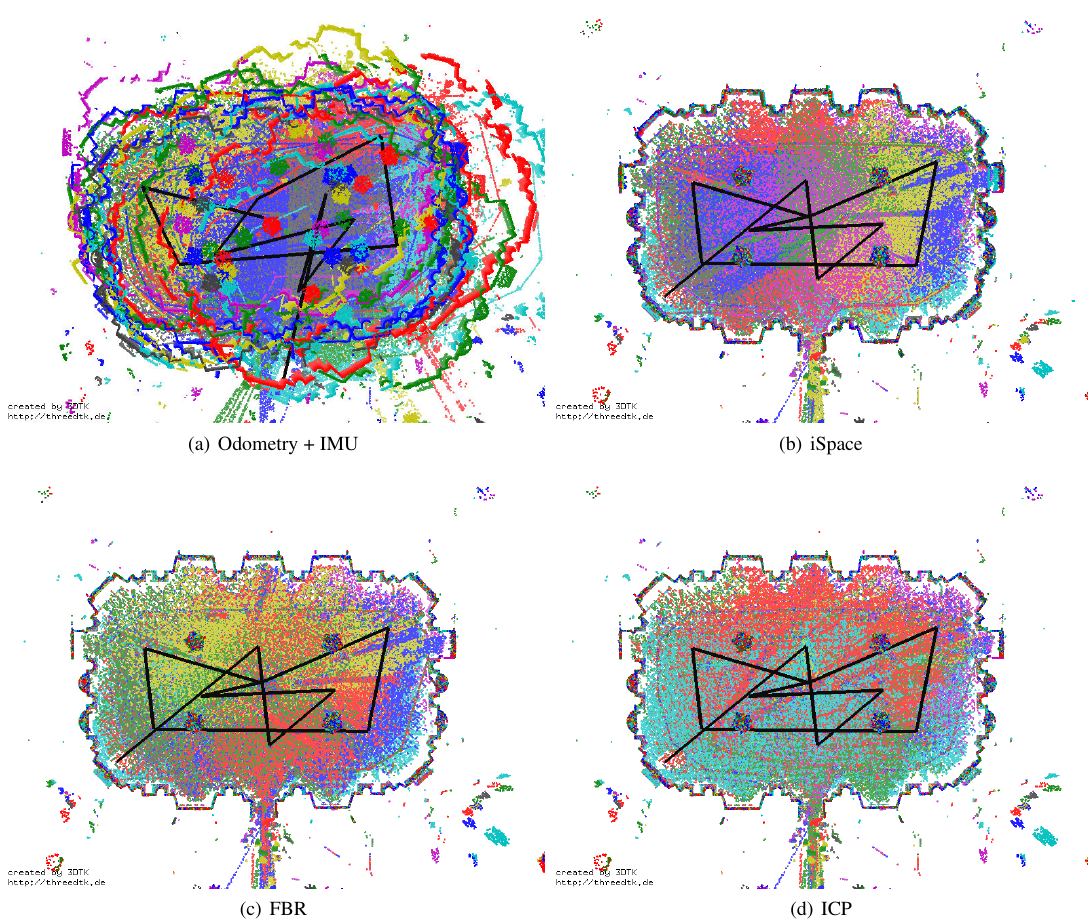
Figure 8: Floor plan of the Imperial Hall at the W¨urzburg Residence. The reconstruction of the garden house in Ostia Antica. The black lines connect the scan positions. Poses from (a) Odometry + IMU, (b) the iSpace system, (c) feature-based registration, (d) the registration with the global ICP using FBR as initial pose